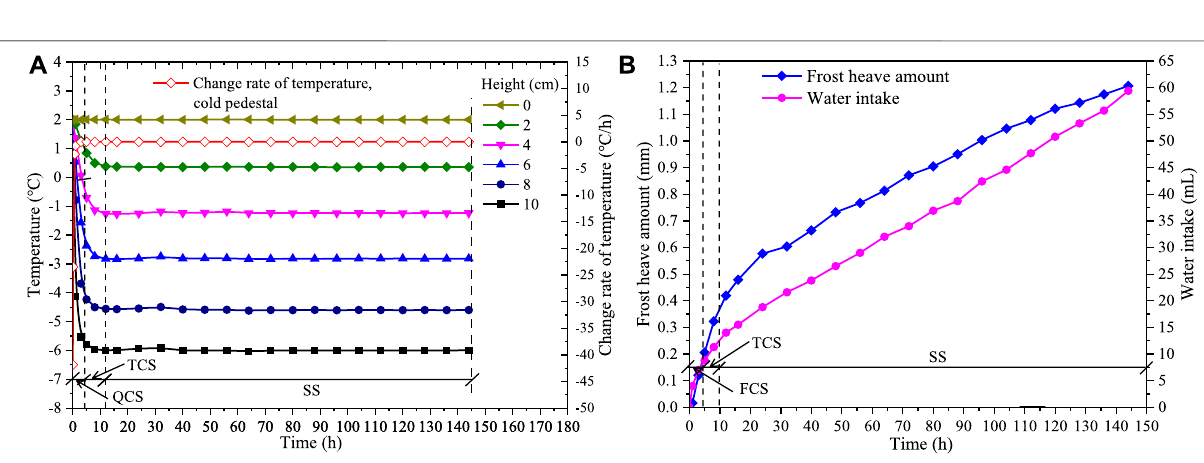
Frontiers in Earth Science |